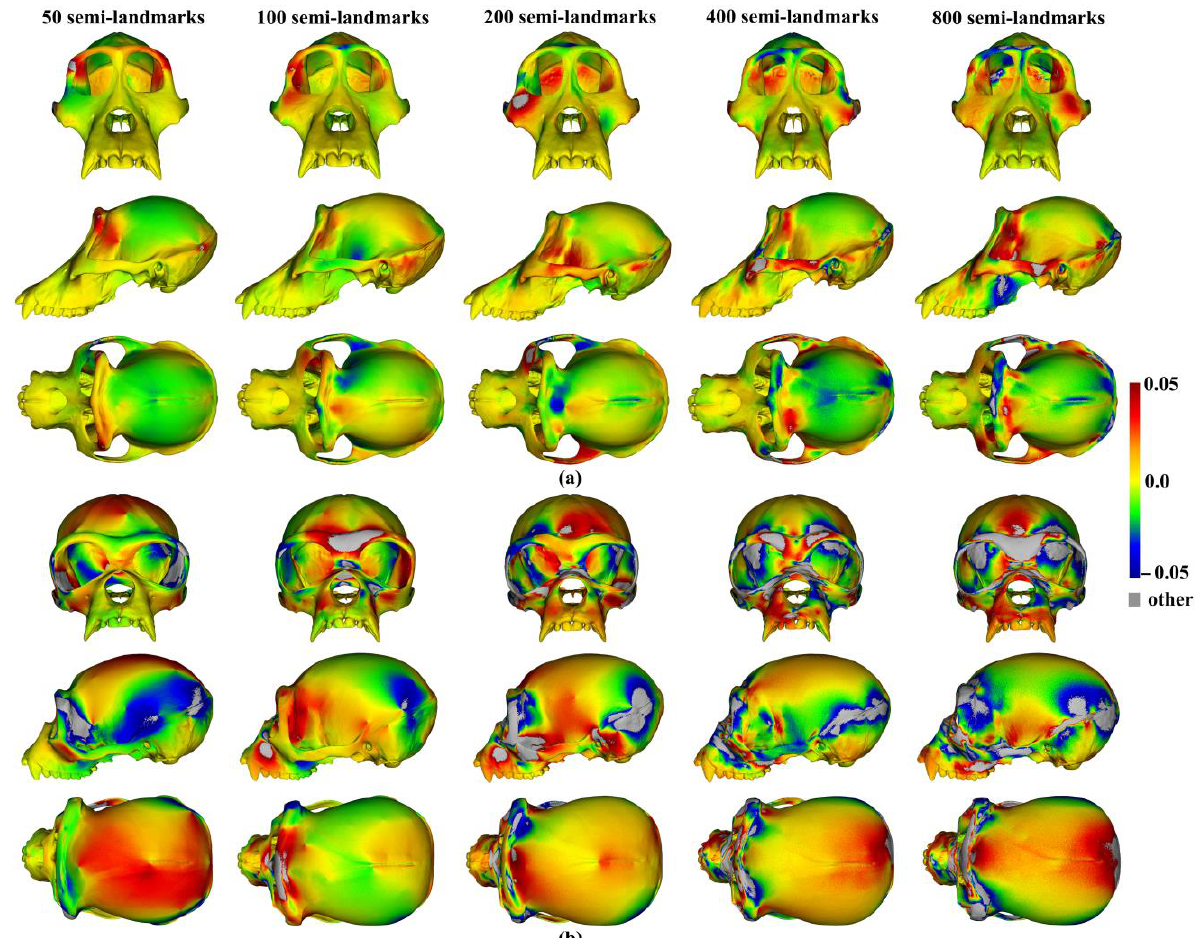
Figure 16. Visualization of the differences in mesh triangle surface areas between the fitted surface shapes of ape crania generated by the sliding TPS (reference) and TPS&NICP (target) approaches after re-semilandmarking and re-warping the template. ( a ) Comparison of predictions corresponding to the maximum centroid size. ( b ) Comparison of predictions corresponding to the minimum centroid size. Scale bar indicates difference in local area between reference and target surfaces expressed as a proportion of the reference area.